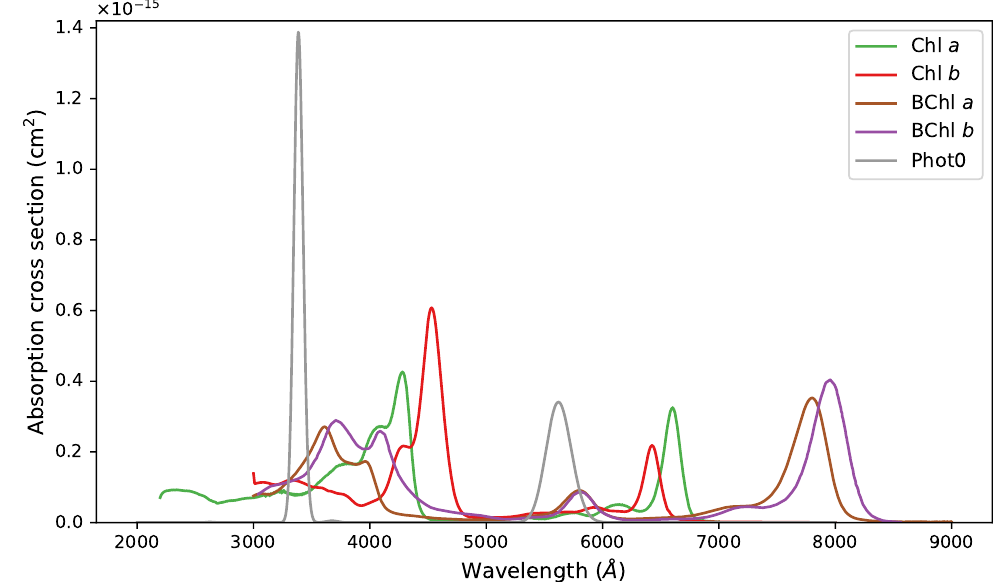
Figure A1. Spectra of the calculated absorption cross sections of the photopigments used in the overlap: Chl a (green), Chl b (red), BChl a (brown), BChl b (magenta), and Phot0